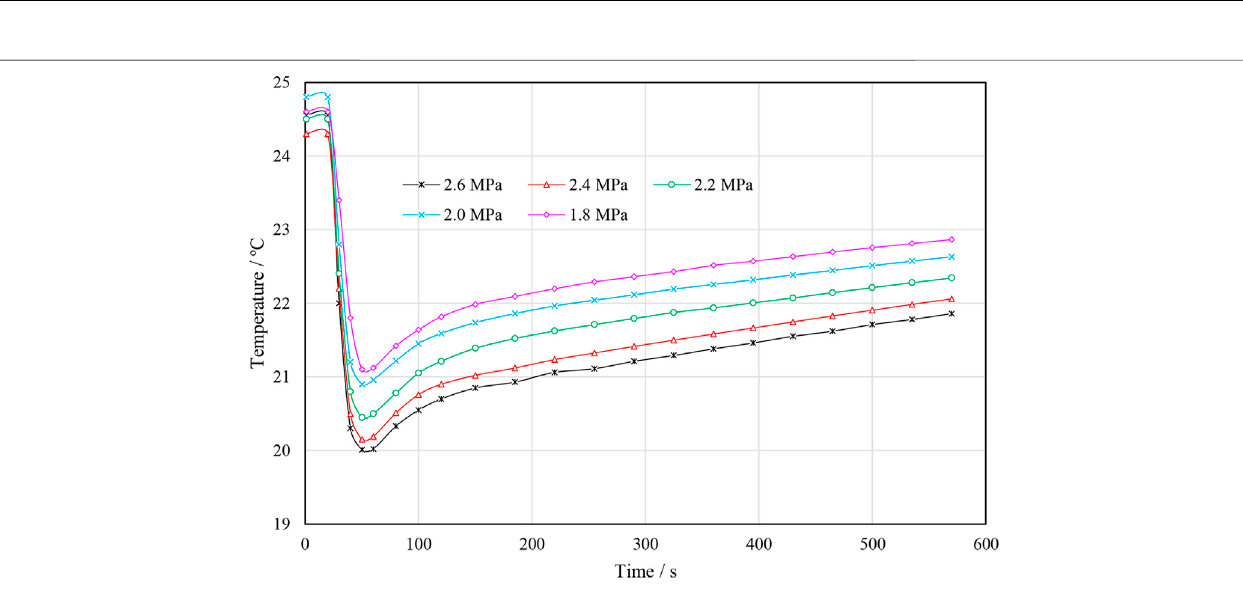
Frontiers in Earth Science |